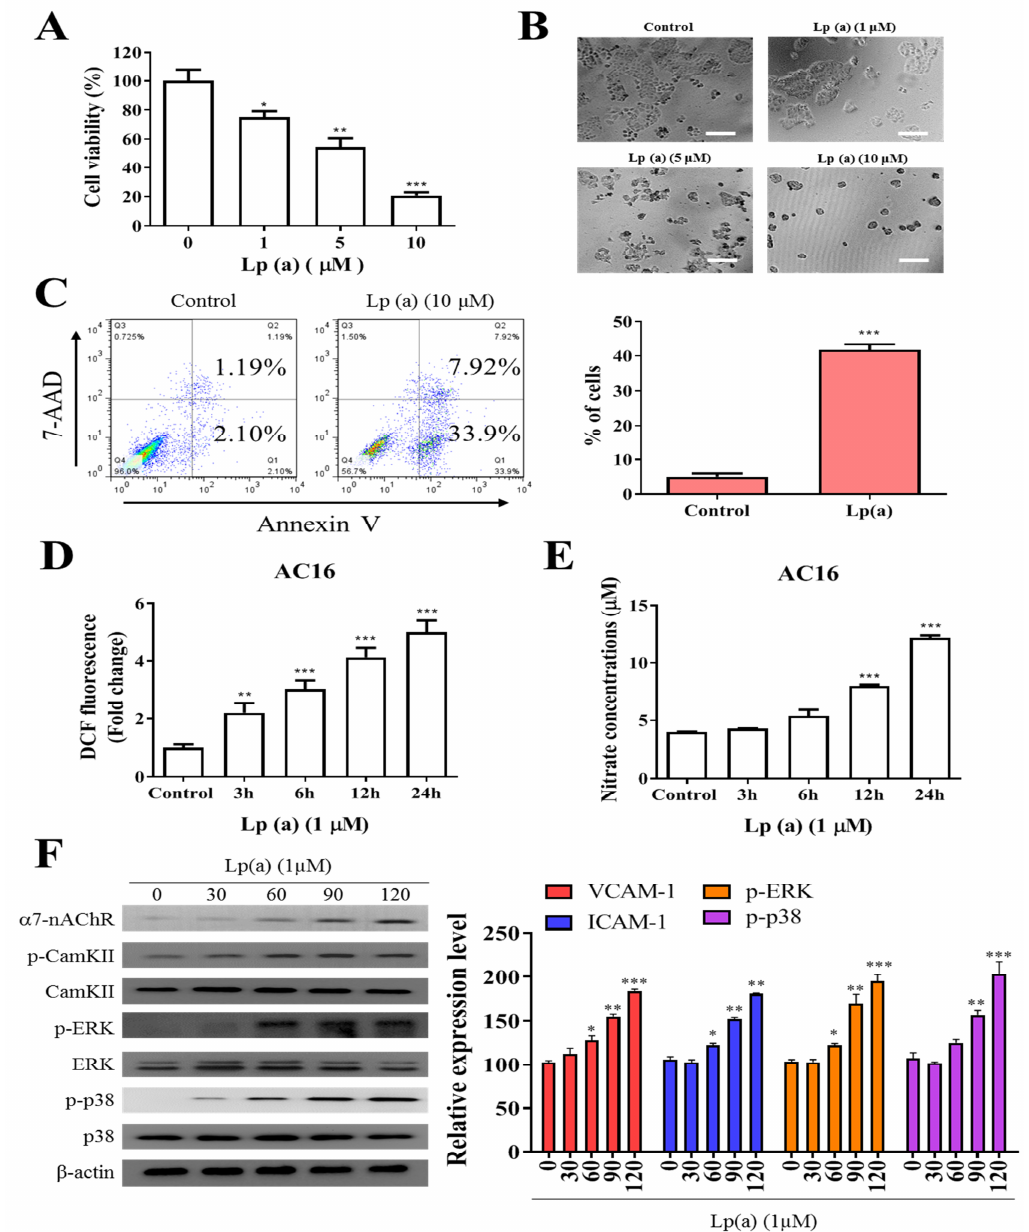
Figure 1 Figure 1. Effect of Lp(a) on reactive oxygen species (ROS) production and α 7-nAChR (nicotinic acetylcholine receptor)- mediated phosphorylation in Ventricular cardiomyocyte AC16 cells. ( A ) Cell viability was significantly reduced in 5 and 10 µ M Lp(a)-treated groups compared to control cells detected for 5 and 10 µ M Lp(a)-treated groups compared to control cells. ( B ) Lp(a)-induced alterations in morphology after exposure to different concentration of Lp(a), ( C ) Lp(a)-induced apoptosis was detected using Annexin V-PE/7-AAD dual staining. ( D ) The cellular redox status was determined using 6-carboxy-2 (cid:48) ,7 (cid:48) -dichlorodihydrofluorescein diacetate (carboxy-H2DCFDA). Serum-starved A16 cells was incubated with carboxy-H2DCFDA and treated with Lp(a) (1 µ M) for the indicated time periods, and the fluorescence intensity was quantitated. ( E ) Serum-starved cells were treated with Lp(a) (1 µ M) for the indicated time periods. The production of NO was determined by measuring nitrate concentrations. ( F ) Western blot analysis showed the concurrent changes in the expression of α 7-nAChR and phosphorylation status of calmodulin-dependent kinase II (CamKII), p38 mitogen-activated protein kinase (MAPK) and extracellular signal-regulated kinase (ERK). * p < 0.05, ** p < 0.01, *** p <